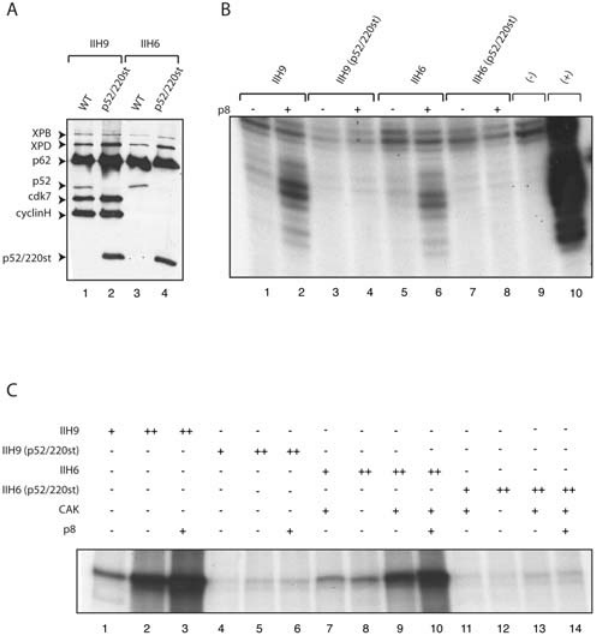
Figure 2. A truncated human p52 peptide (Q202/stop) equivalent to the fly mrn 3 allele can assemble with other TFIIH subunits. The human equivalent of the mrn 3 allele was co-expressed with the remaining TFIIH subunits in insect cells using the baculovirus system and affinity purified using an anti-p44 subunit antibody [19]. (A) Immunopurified recombinant TFIIH complexes (immunoprecipitated by a p44 antibody) containing either wild-type p52 or mutant p52 analyzed by Western blotting using antibodies against XPB, p62, p52, cyclin H and cdk7. The p52[Q202/stop] truncated polypeptide is indicated in the figure. IIH9 denotes a complex containing all TFIIH